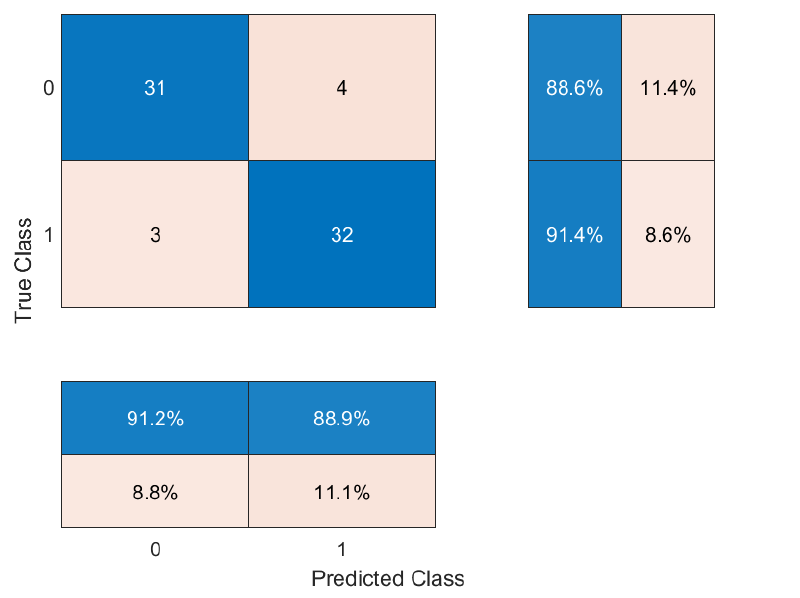
Figure 25. KNN learning results for different neural networks including the noise level (PM10 variant). Table 5. Results for different neural networks including the noise level (PM10 variant)